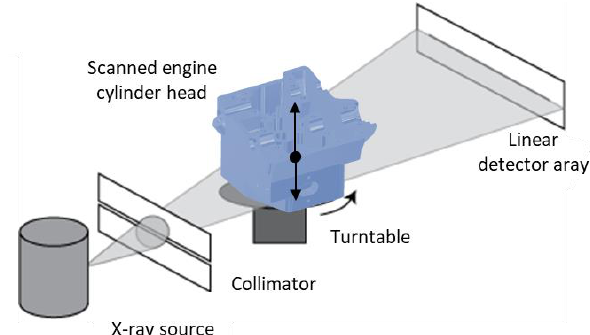
Fig. 12. Methodology tomographic inspection with linear detector